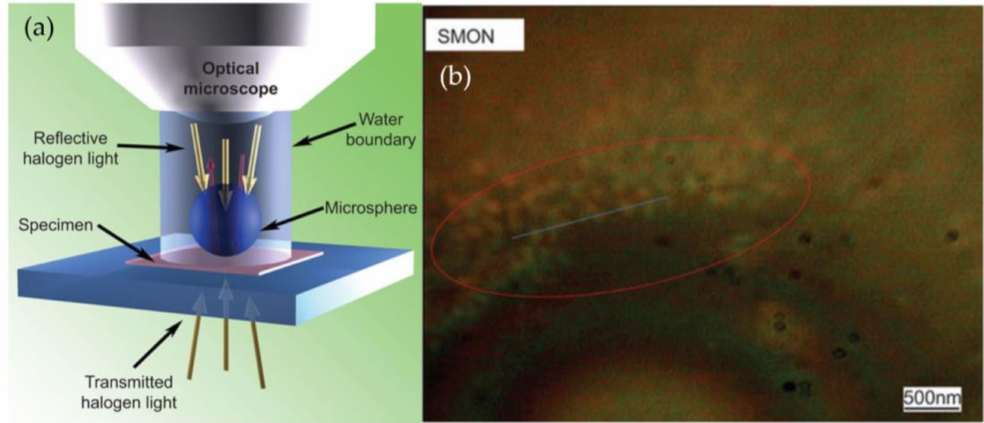
Figure 8. Super Resolution Microscopy with Microspheres (SMON). ( a ) Schematic of SMON instrument showing reflective and transmissive illumination and the location of both specimen and microsphere. ( b ) Representative SMON image showing adenovirus clusters in solution. Reproduced with permission from [182]. Copyright (2013) Springer